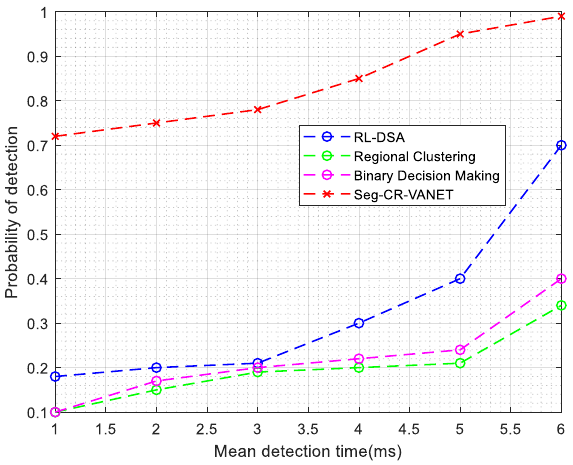
Figure 7. Probability of detection vs. mean detection time.